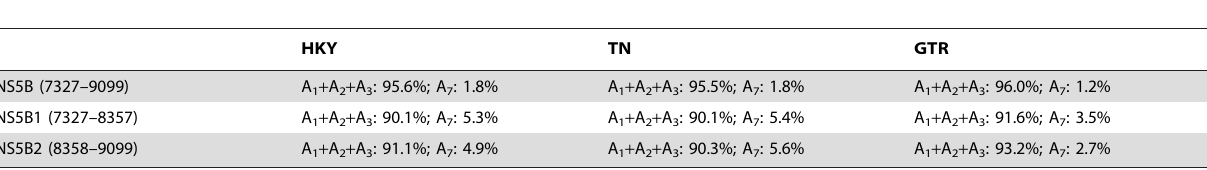
Table 4. Likelihood mapping of NS5B gene sequences of genotype 6